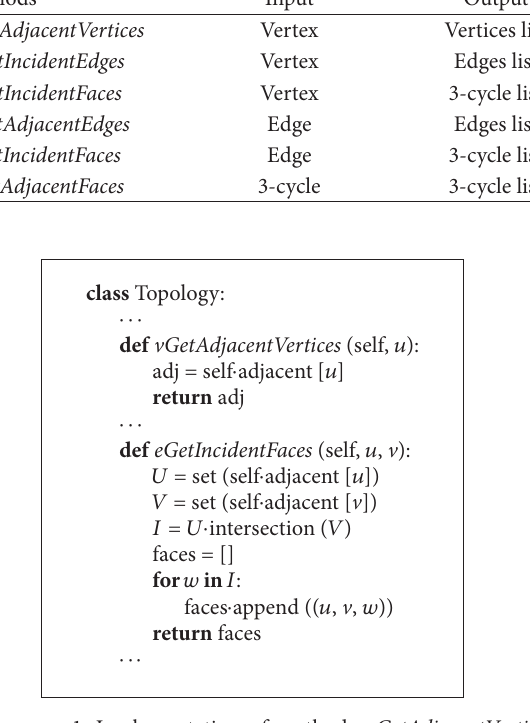
Algorithm 1: Implementation of methods vGetAdjacentVertices and eGetIncidentFaces. Table 2: Classification of explicit and implicit topological methods implemented in TopTri